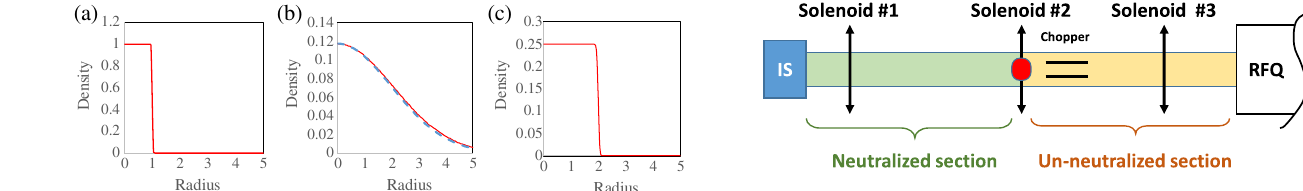
FIG. 2. Illustration of the evolution of a beam with initial uniform current density distribution (a) as it expands due to thermal velocities, propagates through a thin focusing lens (b), and returns to a uniform density distribution in the image plane of that lens (c). The plots show analytical calculations of the current density distributions in MathCad. Density and radius are nor- malized by the initial density in the center of the beam and the initial beam radius. The distance between the lens and the image plane is twice the distance between the emitter plane and the lens. The dashed blue line in (b) shows a Gaussian fit.